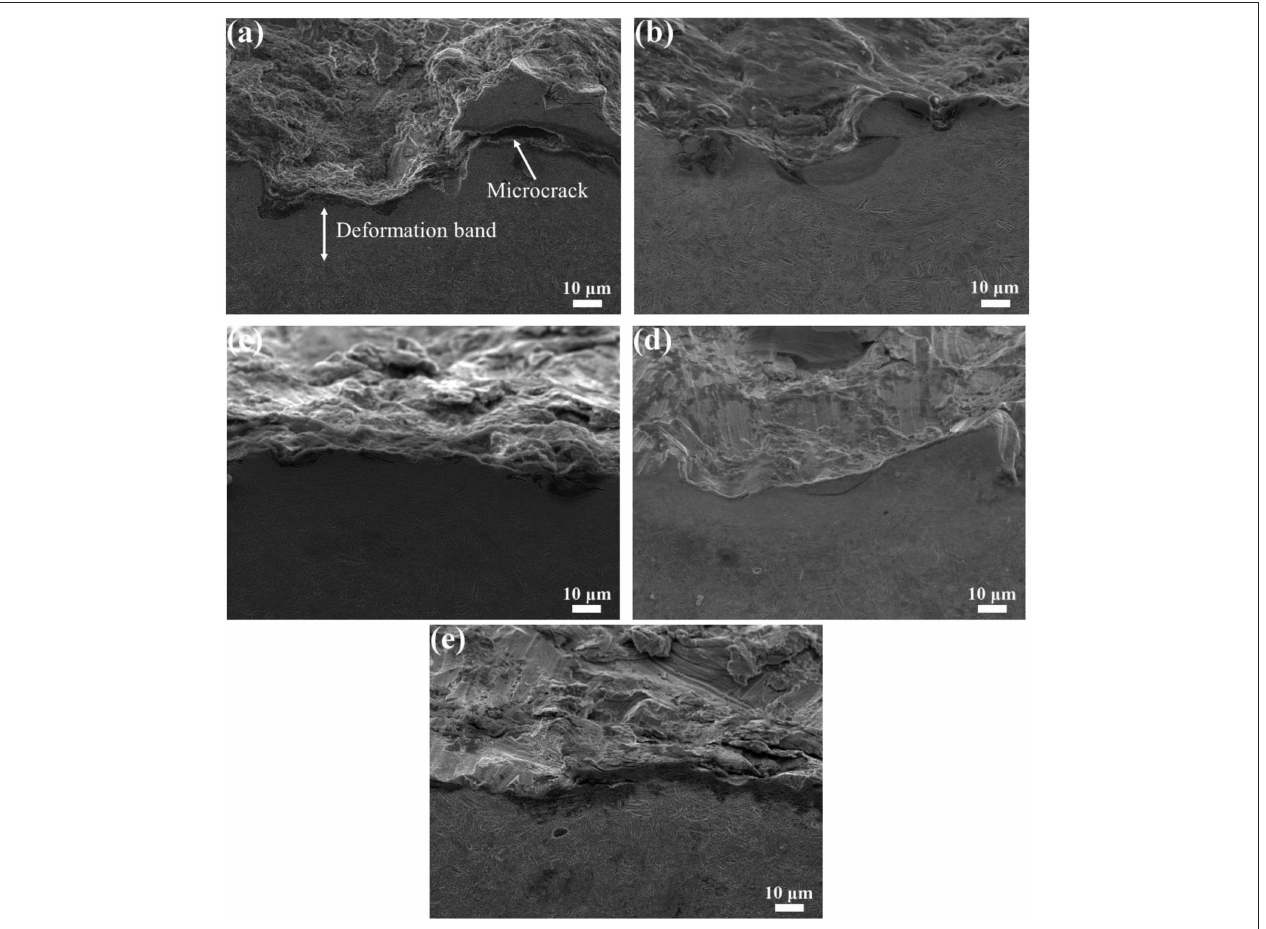
FIGURE 7 | Polished and etched cross sections of worn steel surfaces with different carbon contents as examined in SEM. (a) 0.32 wt.%, (b) 0.35 wt.%, (c) 0.40 wt.%, (d) 0.46 wt.%, (e) 0.55 wt.%.